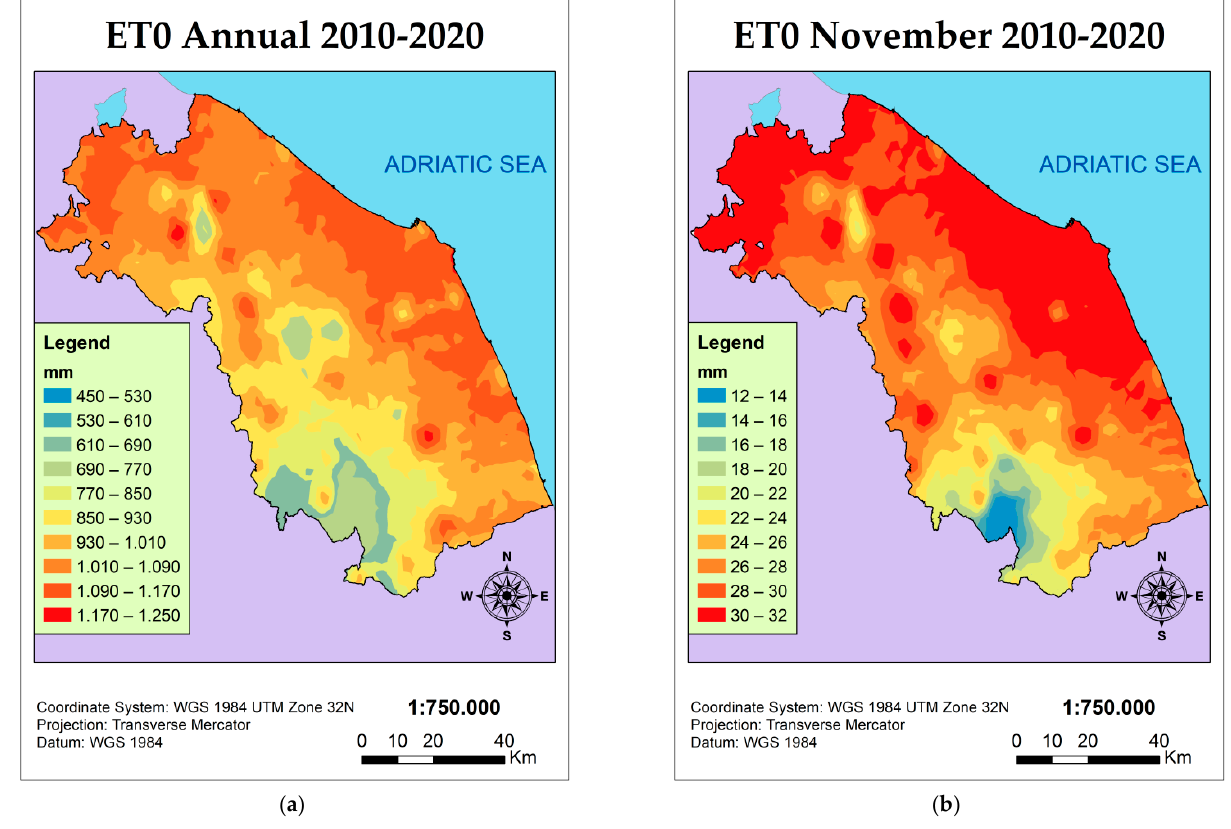
Figure 6. Interpolation of the ET0 from 2010 to 2020, in the study area for the year ( a ) and for November ( b ).